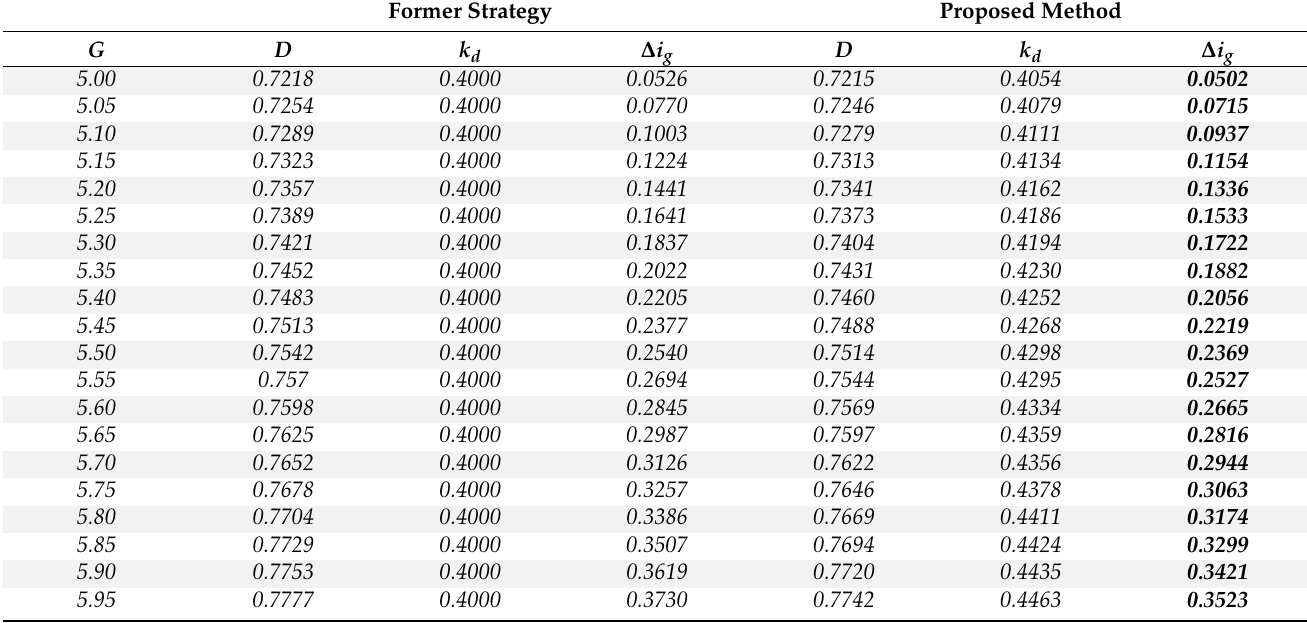
Table 4. Optimal parameter values and the input current ripple obtained from the numerical experiments considering the former strategy and the proposed